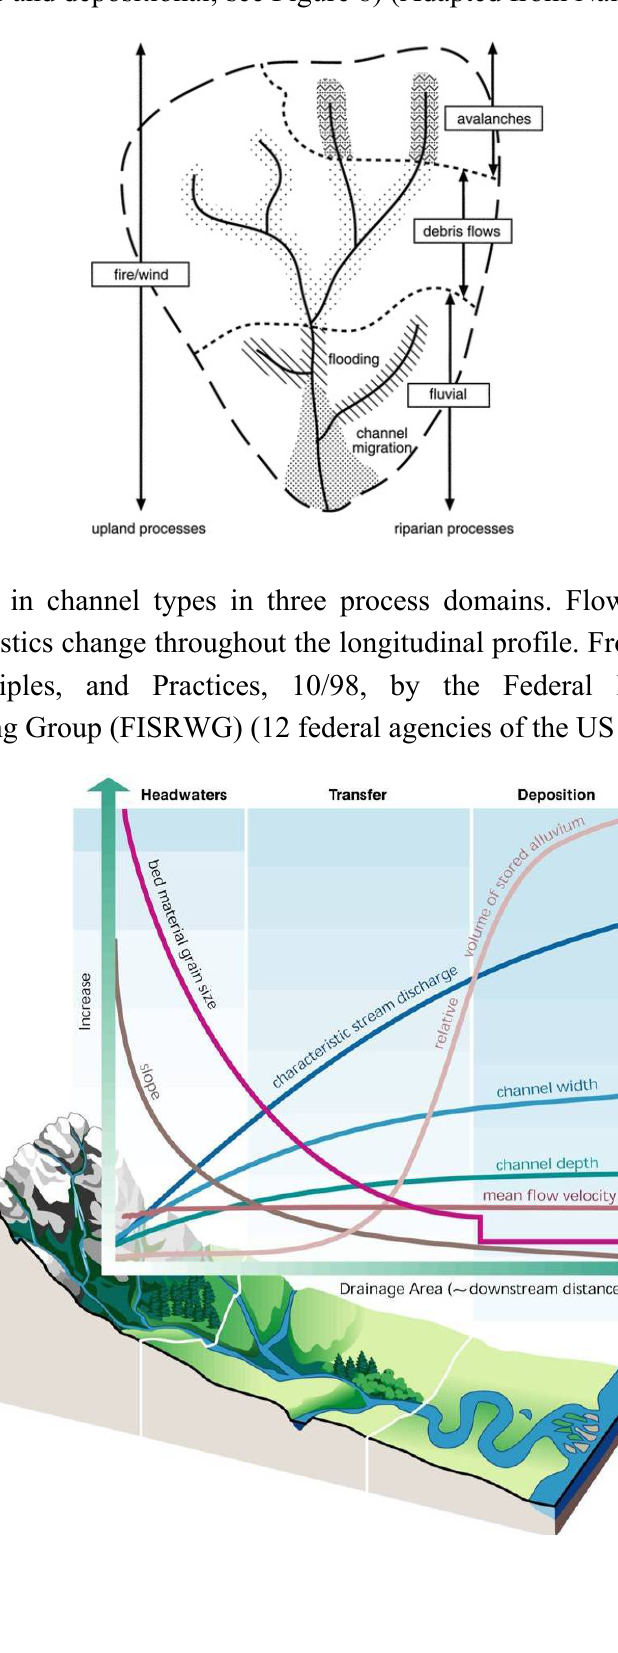
Figure 7. Typical coarse-scale riverine process domains (dotted lines) for Pacific Northwest drainage basins. The shadings in each domain represent different channel types (headwater, transfer and depositional; see Figure 8) (Adapted from Naiman et al . [57]).